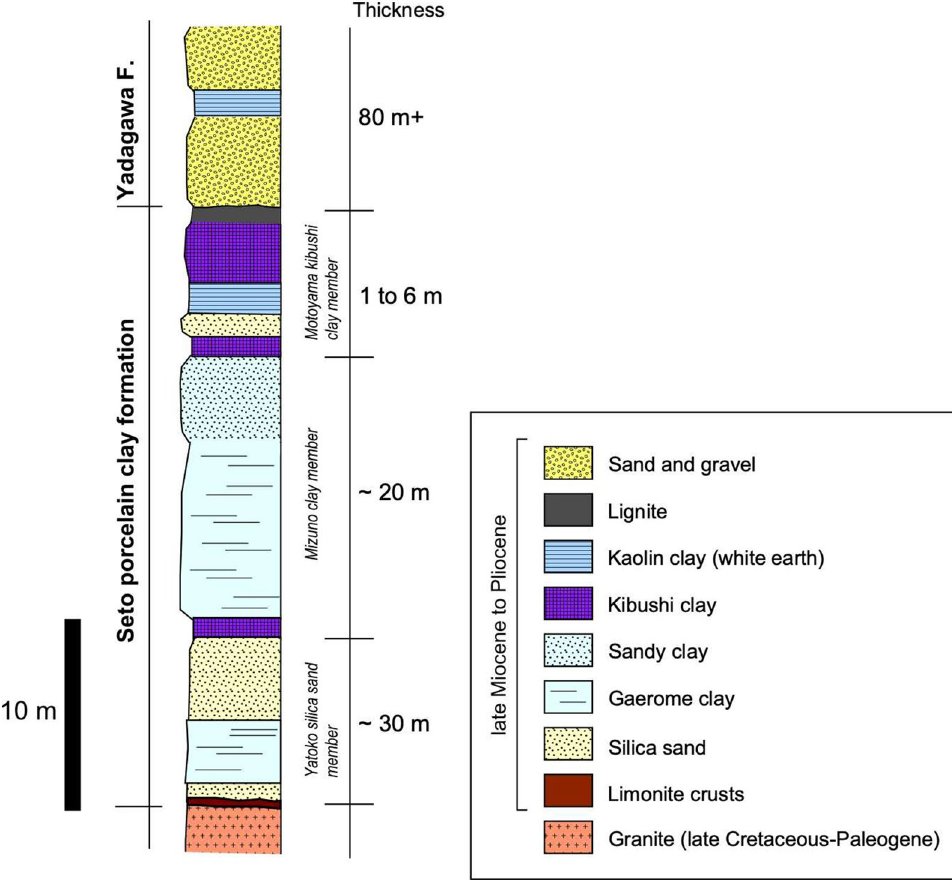
Figure 4. The integrated columnar section of Motoyama kaolin deposit has been modified based on Ref. 12 . Figure 3a is an outcrop ranging from the upper most Mizuno clay member to Yadagawa